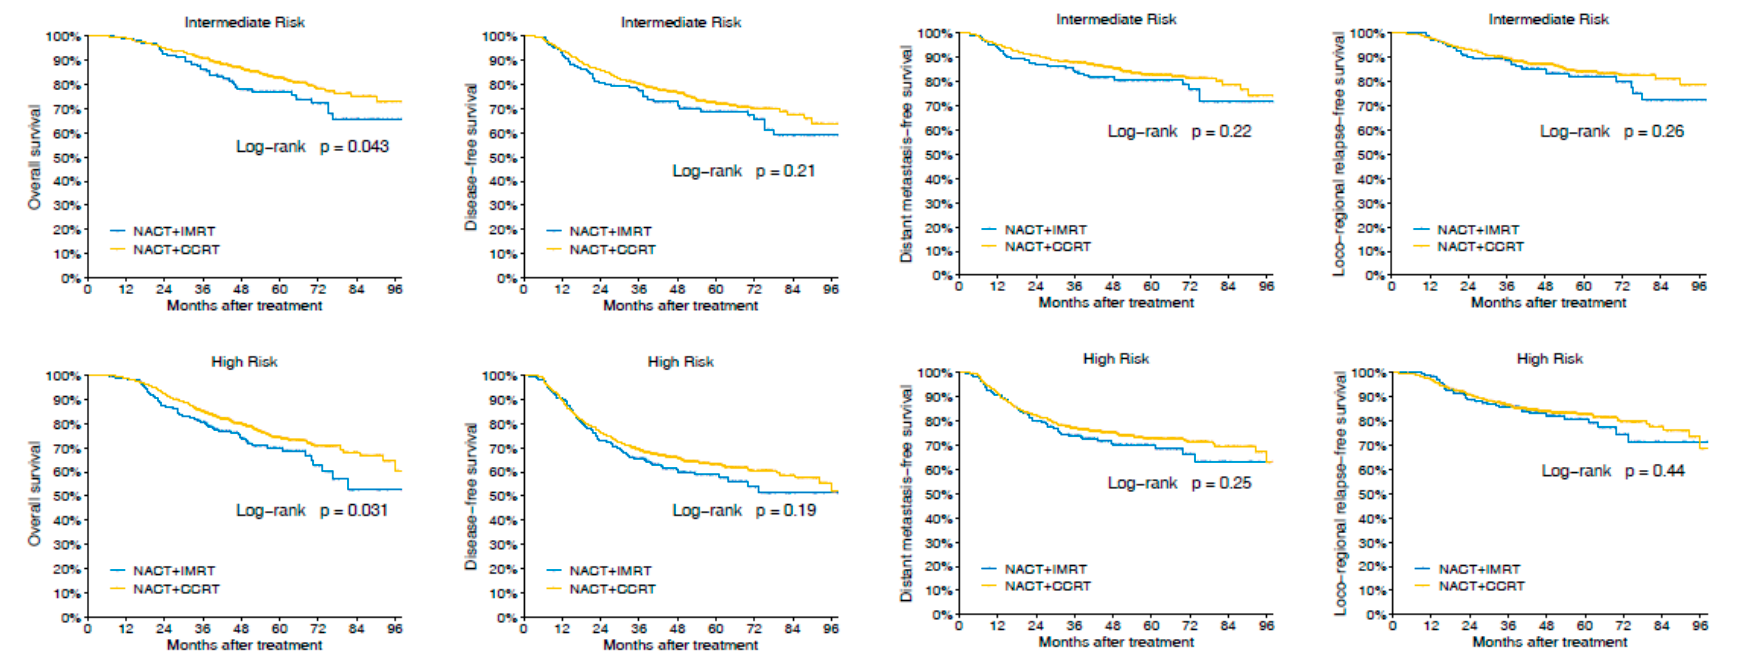
Figure 5. Comparison of the survival rates of neoadjuvant chemotherapy (NACT) + concurrent chemoradiotherapy (CCRT) vs. NACT + intensive-modulated radiotherapy (IMRT) with regard to overall survival, disease-free survival, distant metastasis-free survival, and loco-regional relapse-free survival in patients stratified by TNV groupings.